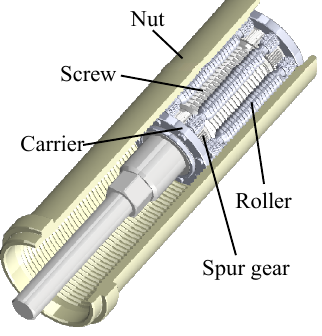
Figure 2. Structure of the inverted planetary roller screw mechanism.